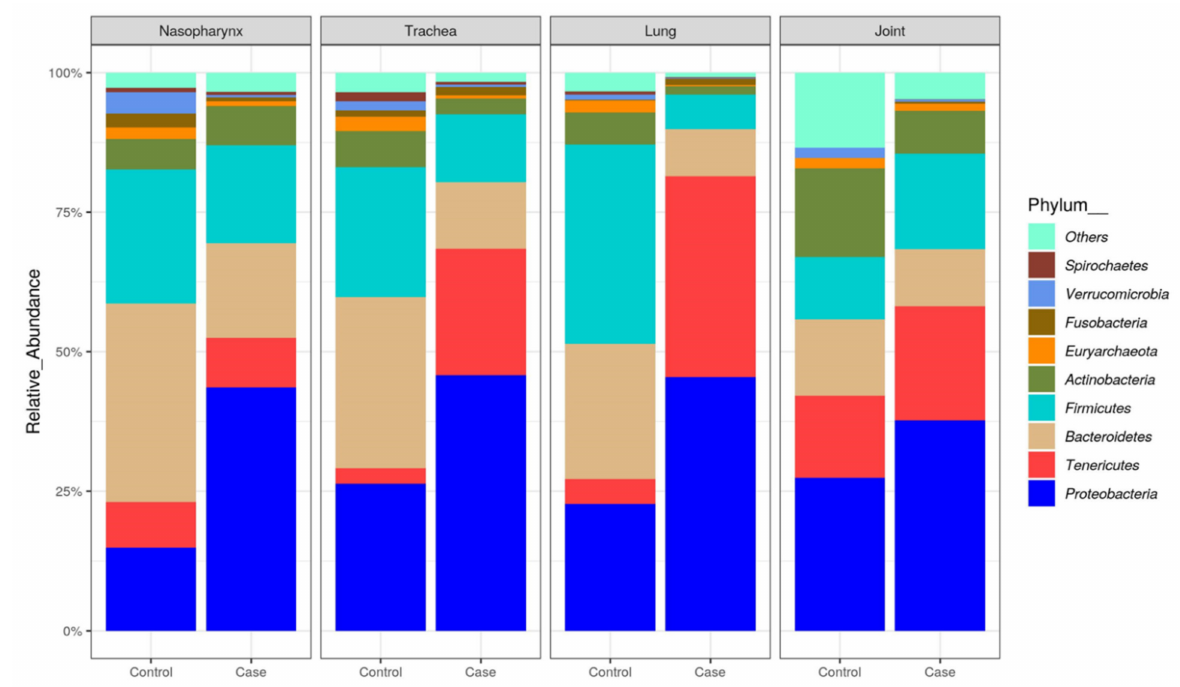
Figure 2. Relative abundance of bacterial 16S rRNA gene sequences at the phylum level observed in the nasopharynx, trachea and lung of cattle succumbed to BRD (cases) as compared to con- trols. All other classified OTUs comprising less than 1% of the total abundance are represented as others/unassigned